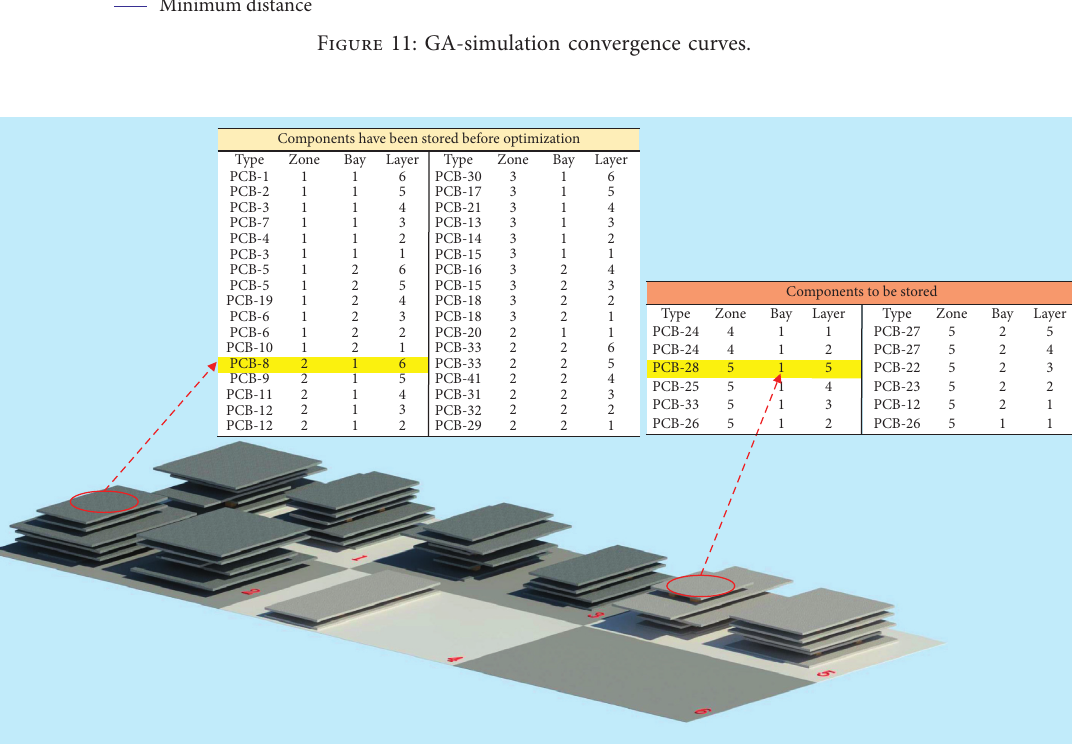
was 46 and horizontal transportation distance was 1275.6 m.